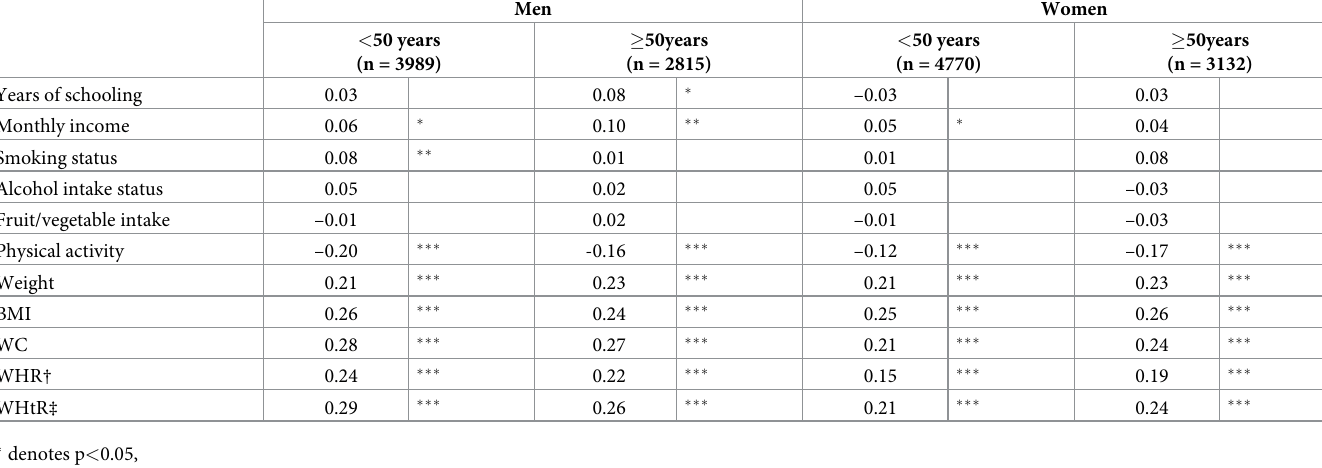
Table 2. Rank correlations of TC with measures of body size and fatness, socio-demographic characteristics, and behavioural factors by age group and